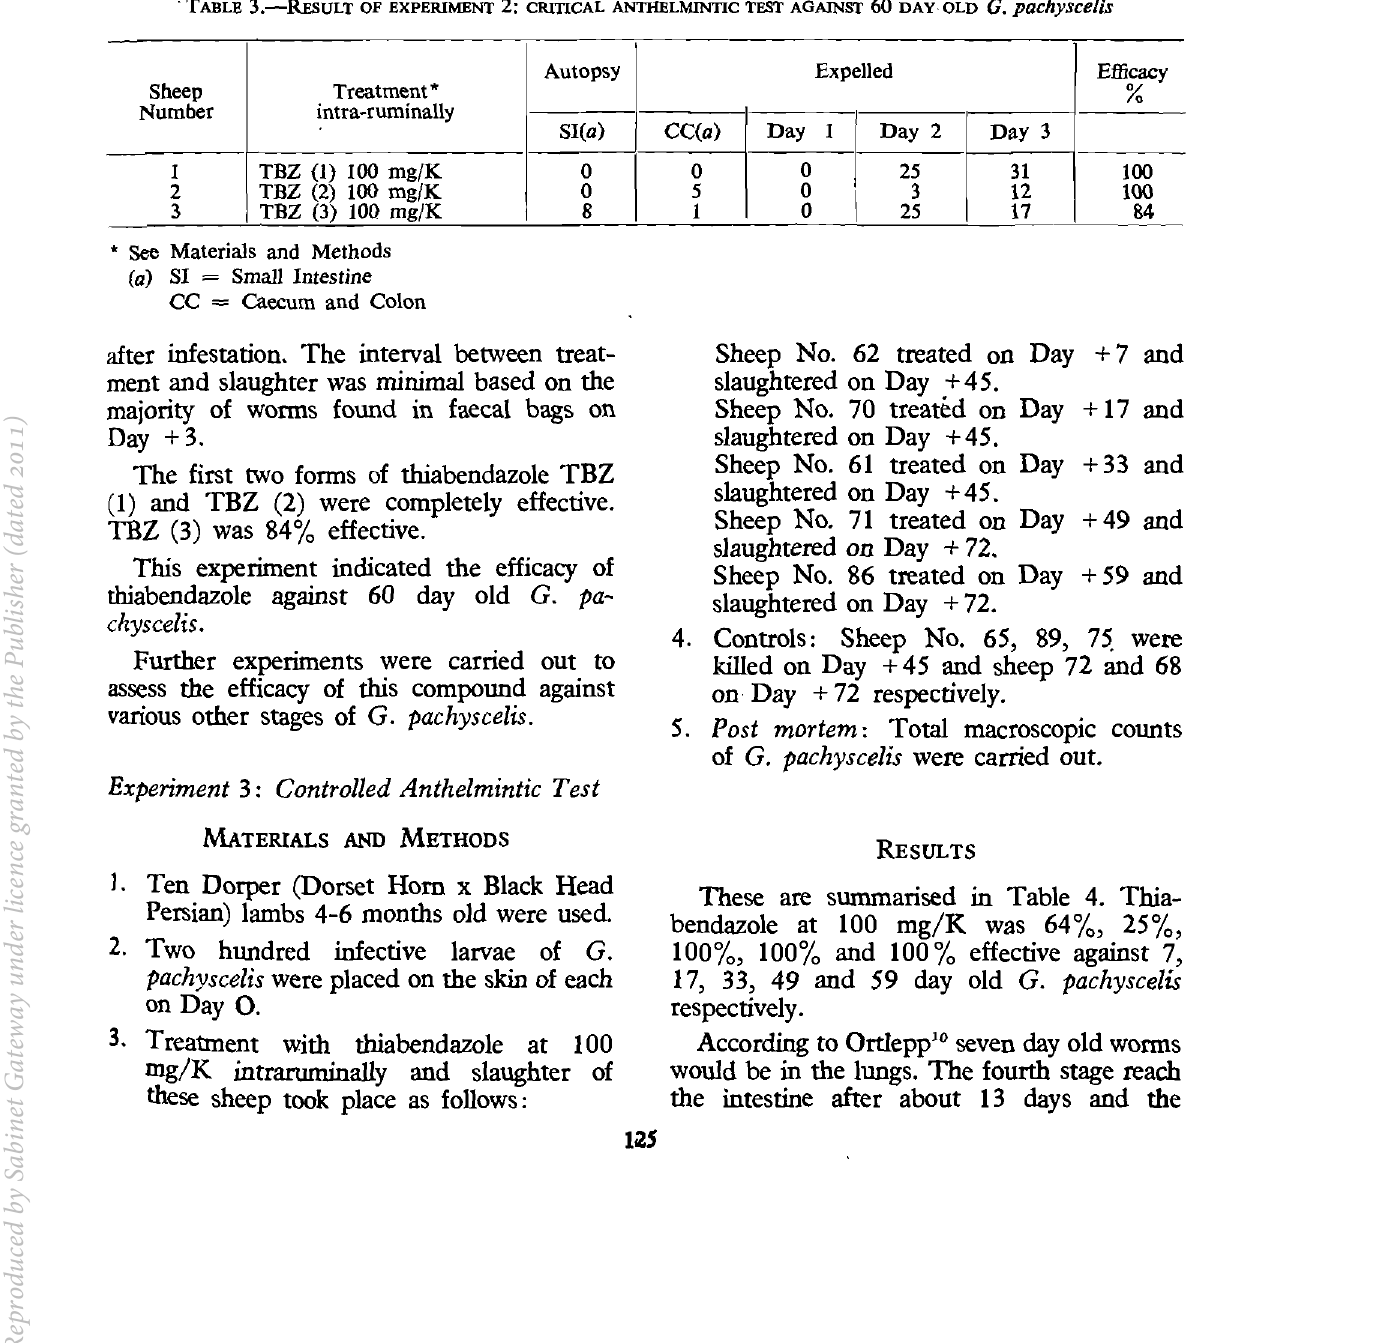
-TABLE 3.-REsuLT OF EXPERIMENT 2: CRITICAL ANTHELMINTIC TEST AGAINST 60 DAY OLD G. pachyscelis